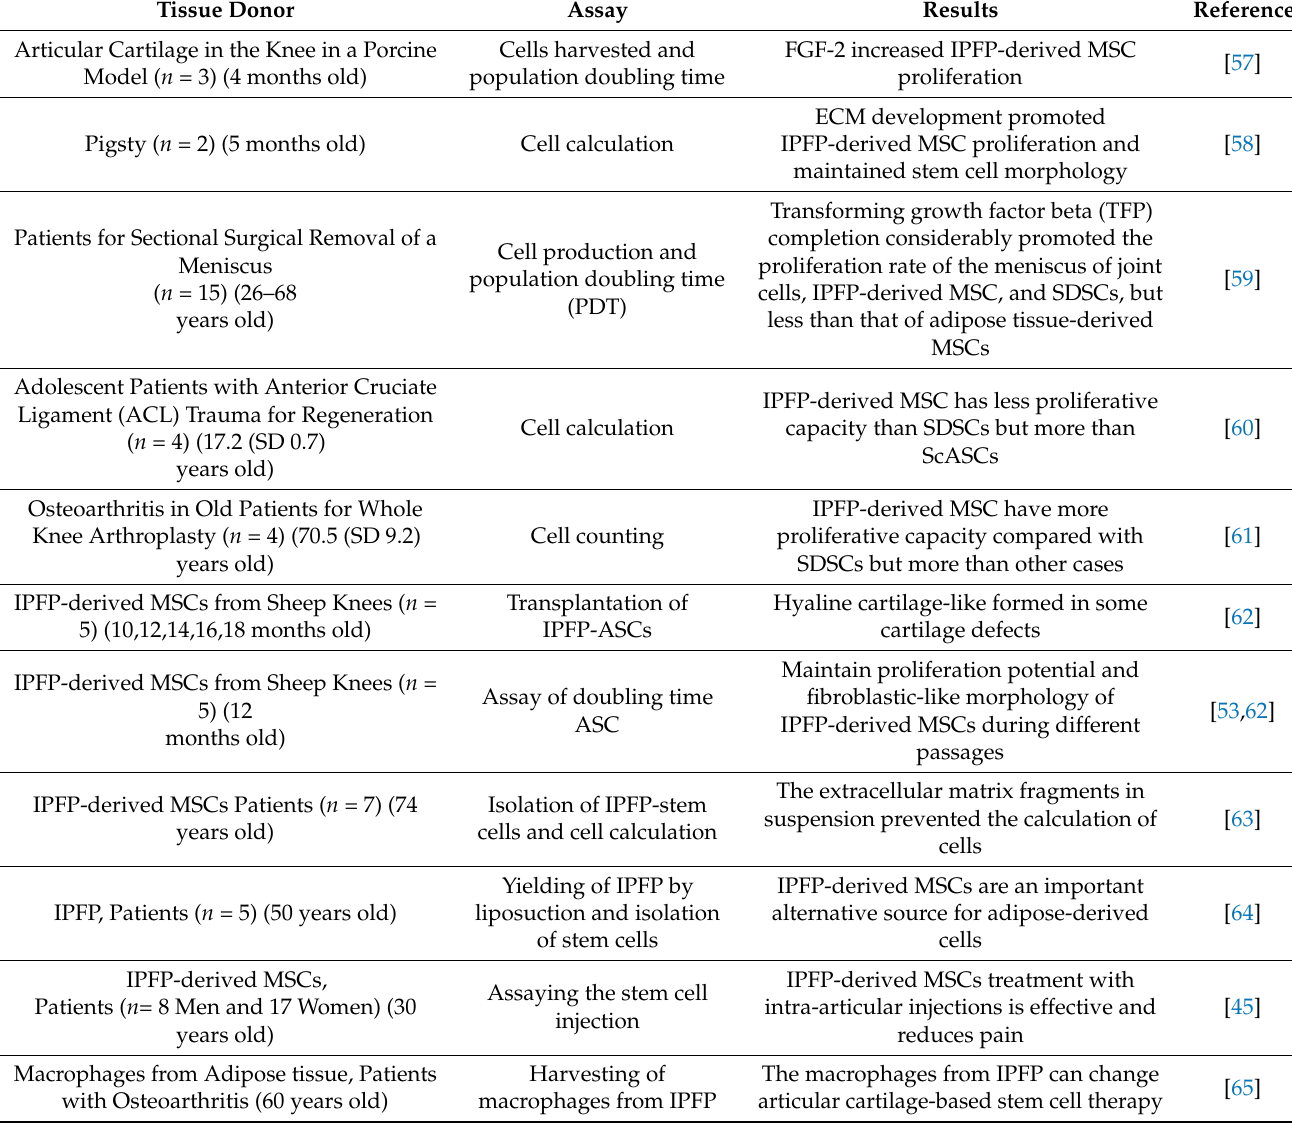
Table 4. Studies on IPFP-derived MSC proliferation and chondrogenic